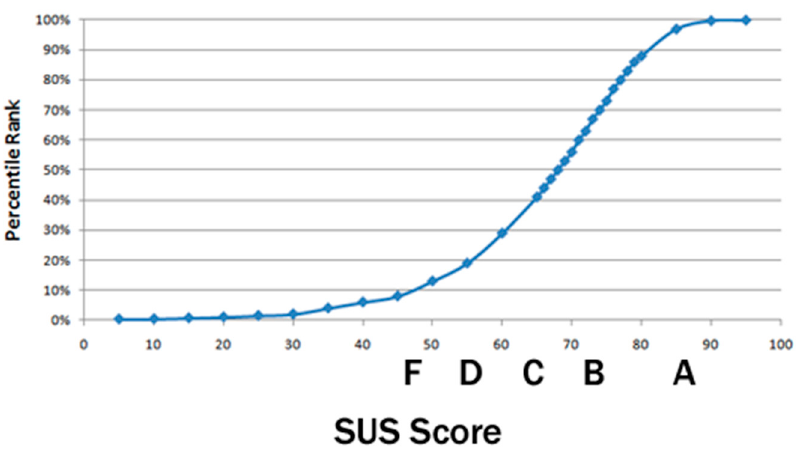
Figure A5. Grading on a curve based on the distribution of all scores (Sauro Jeff, 2016).